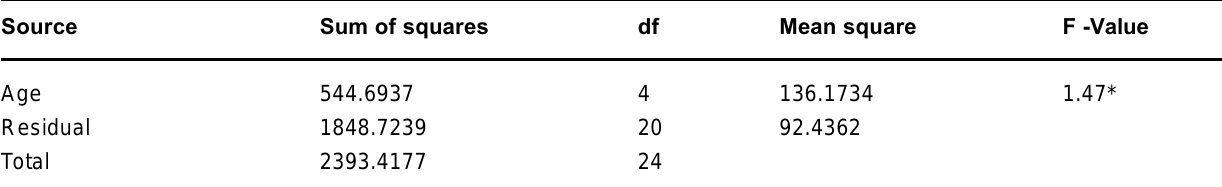
TABLE 2 - One-way analysis of variance